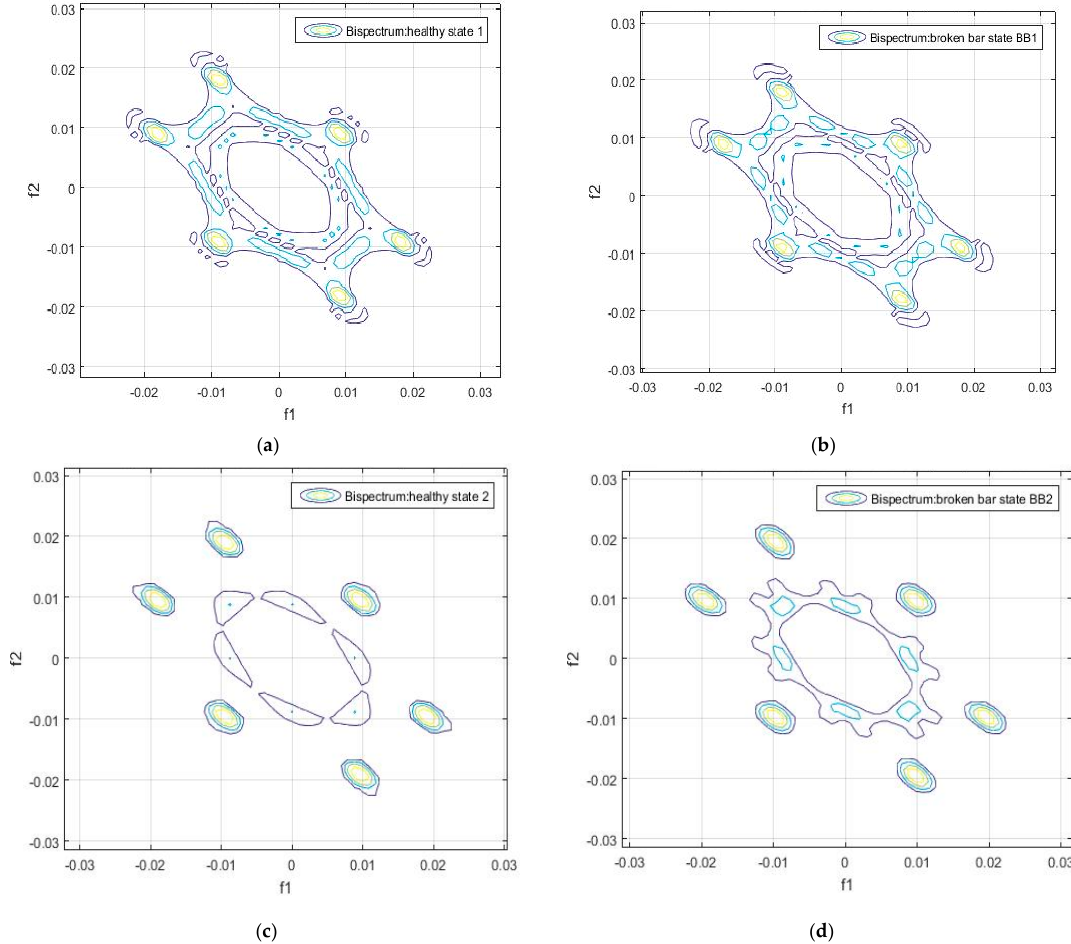
Figure 4. Contour of the bispectrum of the motor flux signal: ( a ) Sample 1 of the healthy motor, ( b ) Sample 1 of the damaged motor, ( c ) Sample 2 of the healthy motor, ( d ) Sample 2 of the damaged motor.